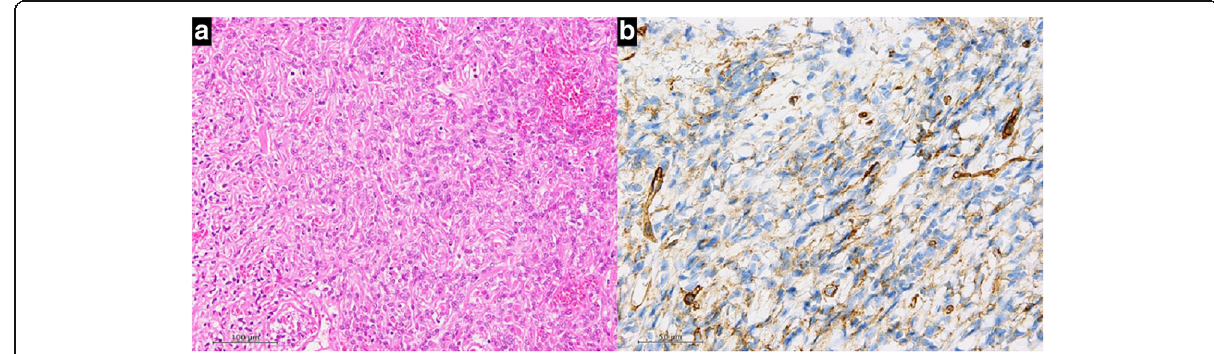
Fig. 3 a Hematoxylin and eosin staining. Low power magnification (× 200) demonstrates a “ patternless ” architecture with spindle-shaped cells, abundant stromal collagen bundles, and ectatic vessels. b CD34 staining demonstrates diffuse positive staining at high power magnification